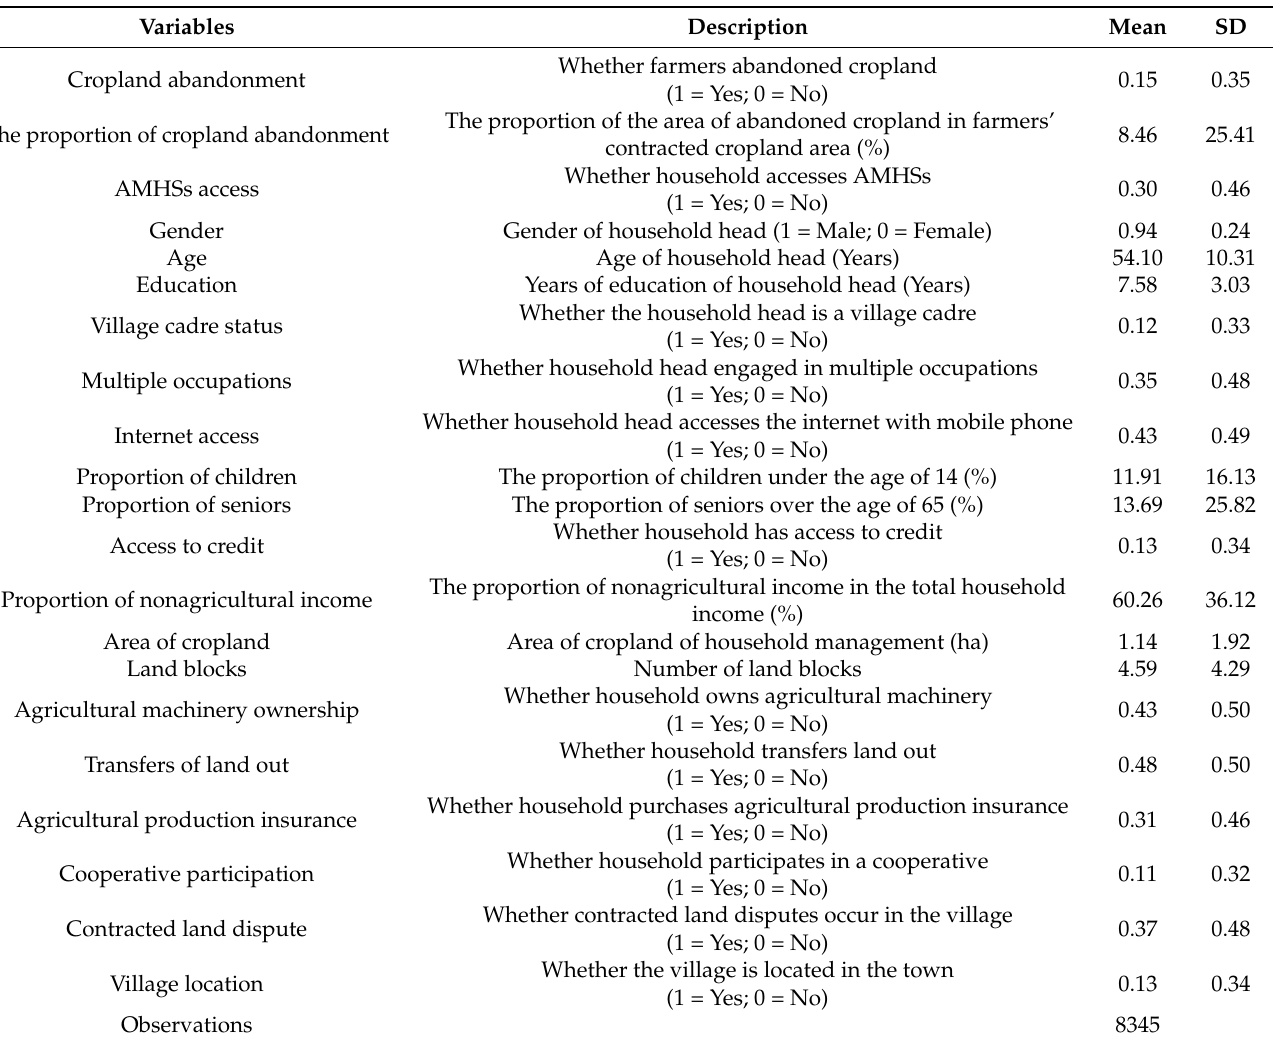
Table 1. Descriptive statistics analysis